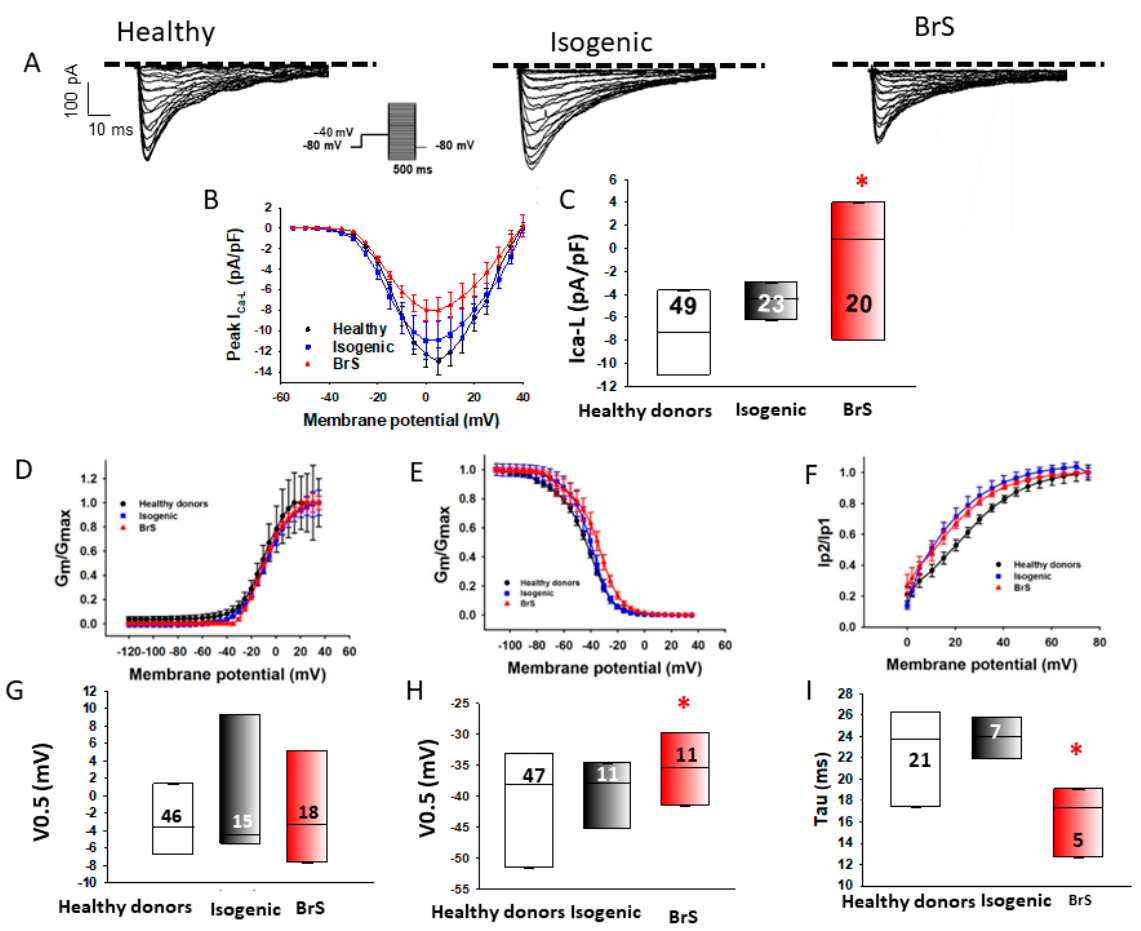
Figure 4. Reduction of L-type calcium channel currents in hiPSC-CMs from the BrS patient. Peak L-type calcium (I Ca-L ) and sodium channel (I Na ) currents were analyzed in hiPSC-CMs from healthy donors (Healthy), the BrS patient (BrS) and variant-corrected cells (Isogenic). ( A ) Representative traces of I Ca-L in hiPSC-CMs from healthy donors (Healthy), the BrS patient (BrS) and variant- corrected cells (Isogenic). ( B ) I-V curves of I Ca-L from healthy donors (Healthy), the BrS patient (BrS) and variant-corrected cells (Isogenic). ( C ) Median values of peak I Ca-L at − 10 mV from healthy donors (Healthy), the BrS patient (BrS) and variant-corrected cells (Isogenic). ( D ) Activation curves of I Ca-L in hiPSC-CMs from each cell line. ( E ) Inactivation curves of I Ca-L in hiPSC-CMs from each cell line. ( F ) Recovery curves of I Ca-L in hiPSC-CMs from each cell line. ( G ) Median values of the potential at 50% activation (V0.5) of I Ca-L in hiPSC-CMs from each cell line. ( H ) Median values of the potential at 50% inactivation (V0.5) of I Ca-L in hiPSC-CMs from each cell line. ( I ) Median values of the time constants (Tau) of recovery from the inactivation of I Ca-L in hiPSC-CMs from each cell line. Numbers given in ( C ) represent the number of cells for ( B – C ). Numbers given in ( F ) represent the number of cells for ( E , F ). * p < 0.05 versus Healthy according to the analysis of one-way ANOVA with Holm– Sidak post-test.